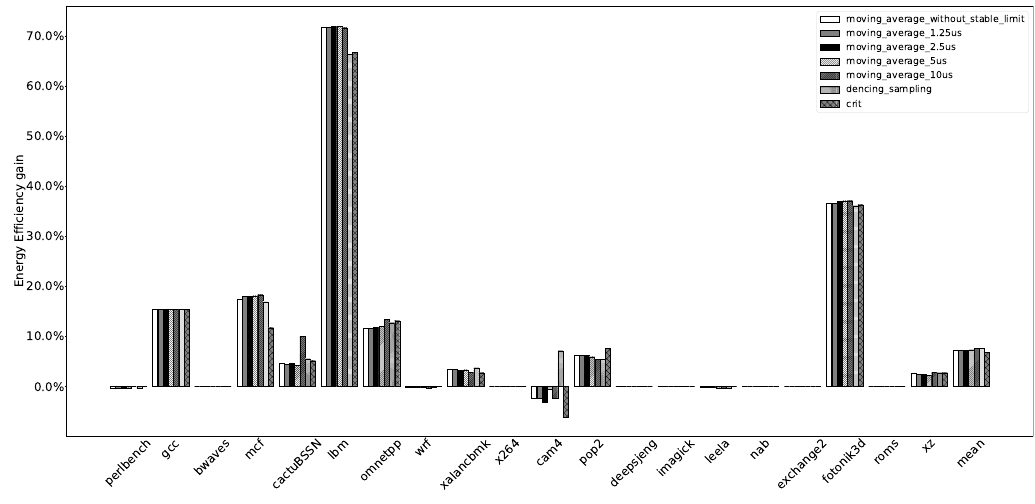
Figure 12. Comparison of power management